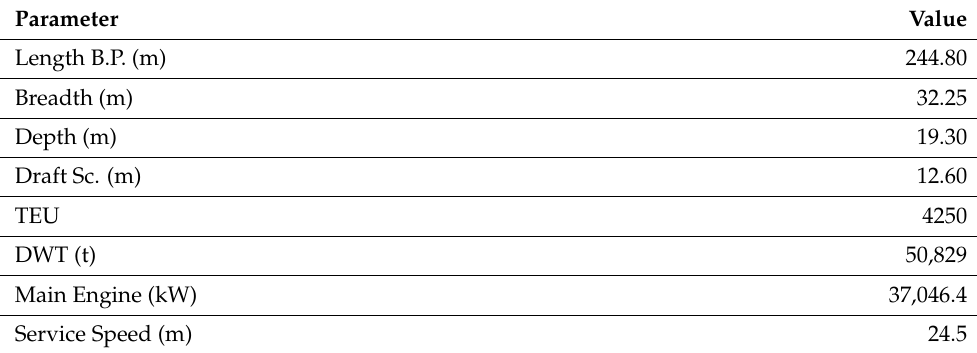
Table 1. Containership’s characteristics.